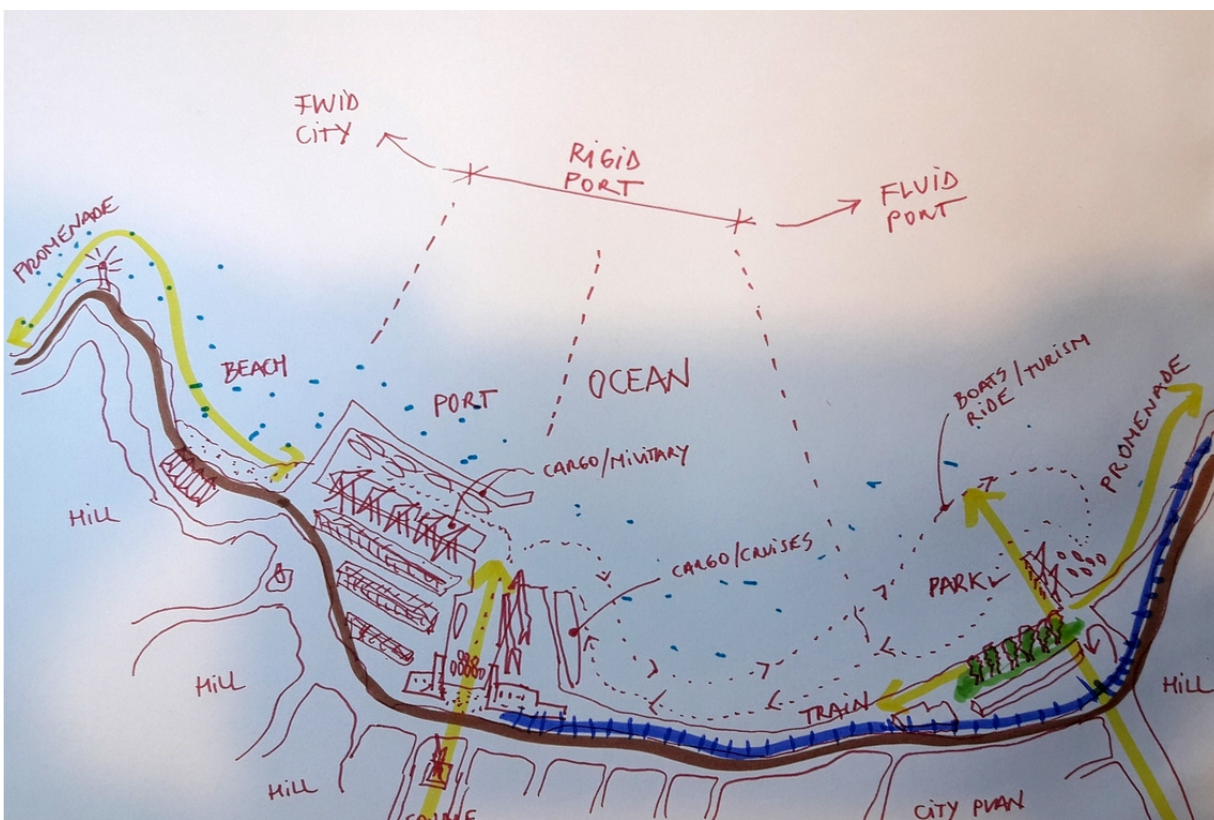
Figure 1. Mental map of the port city of Valparaíso by Cristian Moreno, made for the online course “(Re)Imagining Port Cities.” Source: Courtesy of Cristian